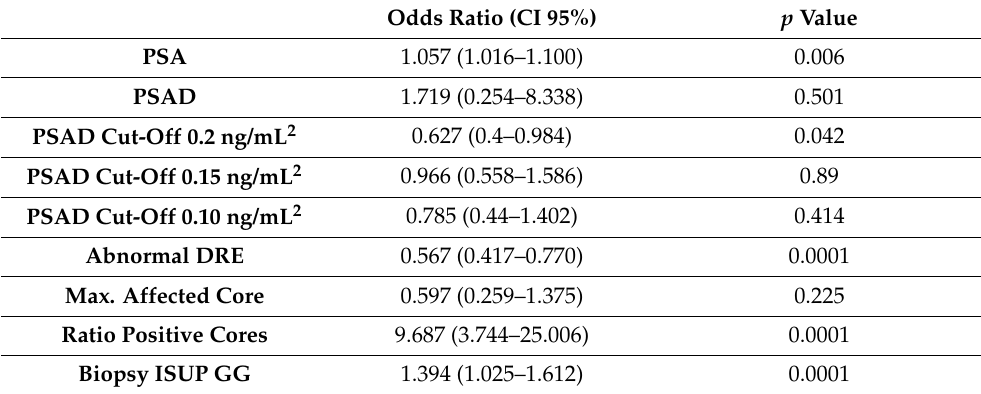
Table 3. Multivariate analyses of preoperative variables for predicting